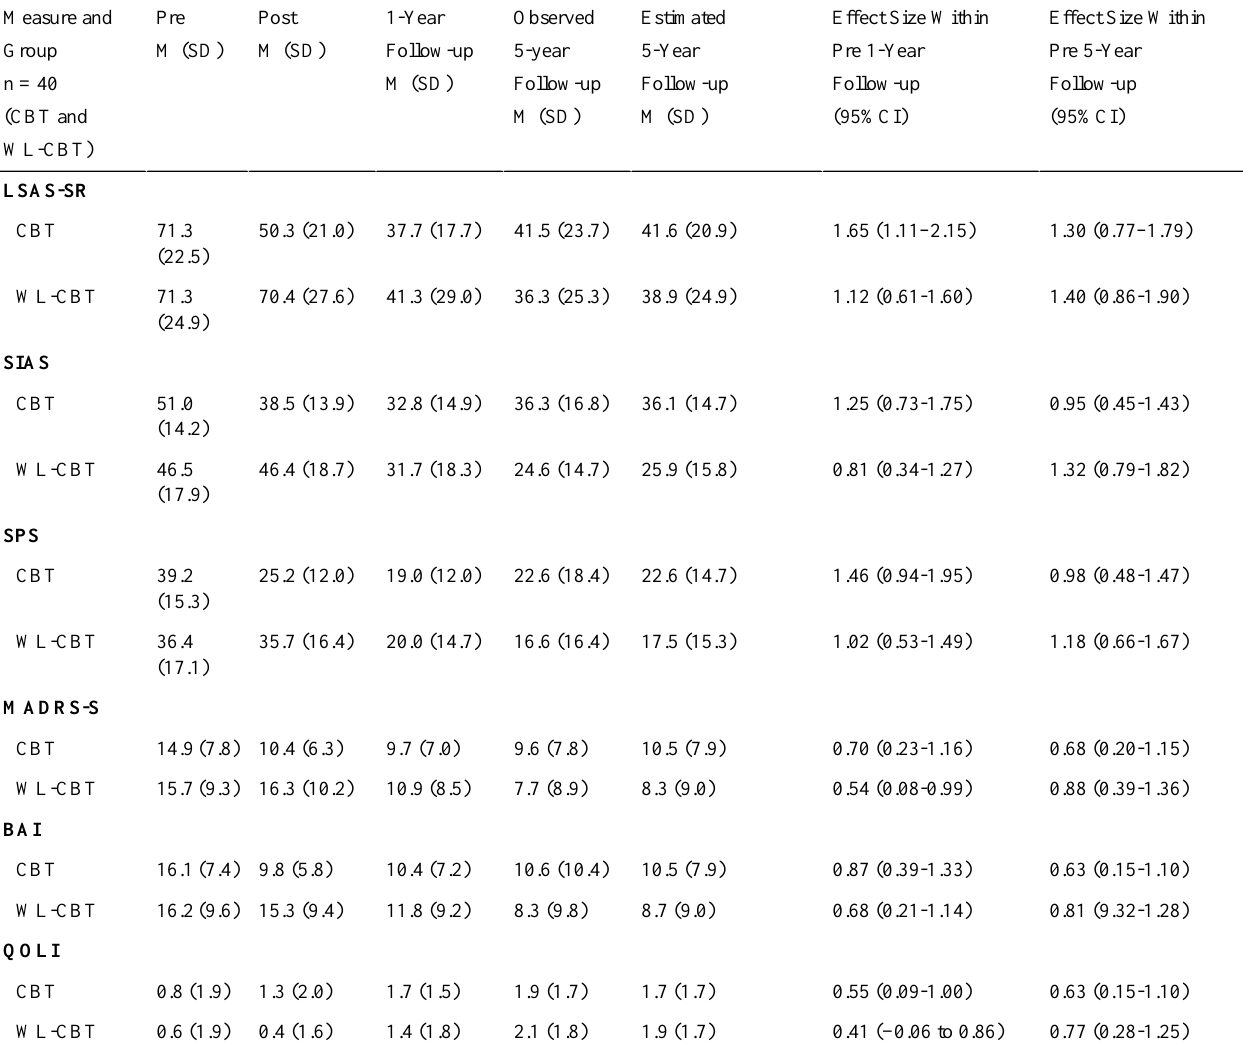
Table 1. Observed and estimated means, SDs, and effect sizes (Cohen’s d ) on continuous outcome